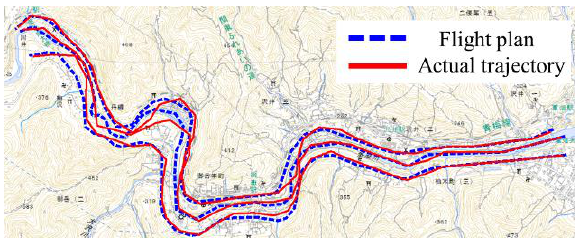
Figure 5. The deviation of actual trajectory from the plan in the preliminary experiment